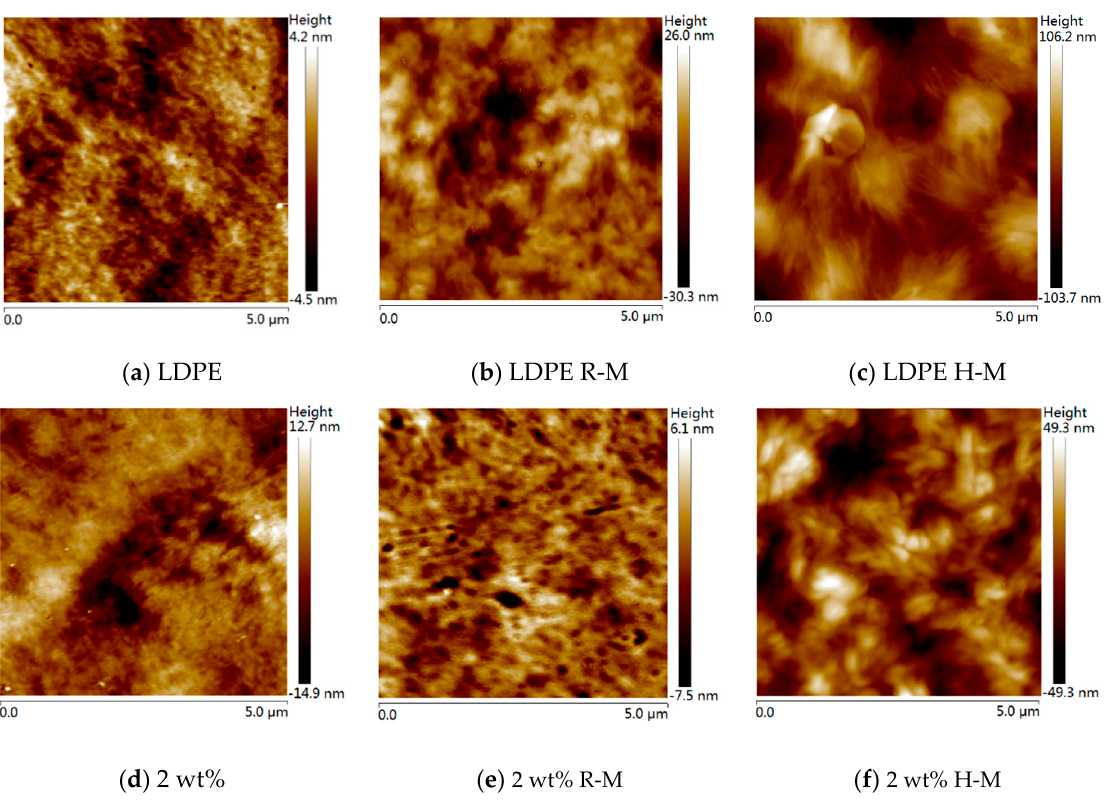
Figure 1. AFM images of the LDPE ( a – c ) and 2 wt% composites ( d – f ) with height maps.